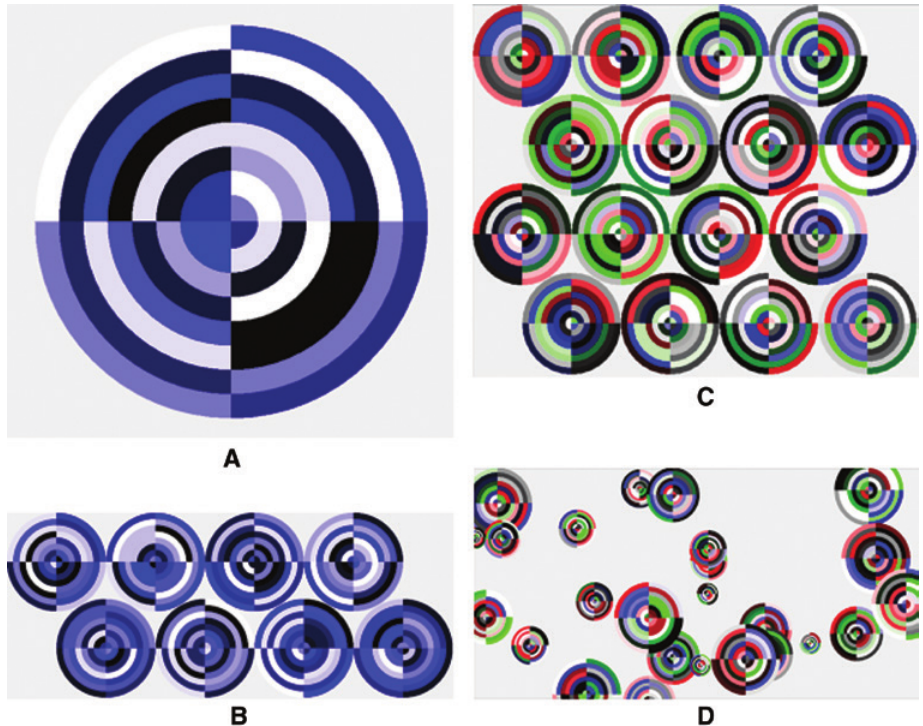
Figure 1: Examples of the Image Representation for the (A) Concentric Class, (B) Parallel Class, (C) Pixels Class, and (D) Canvas Class.